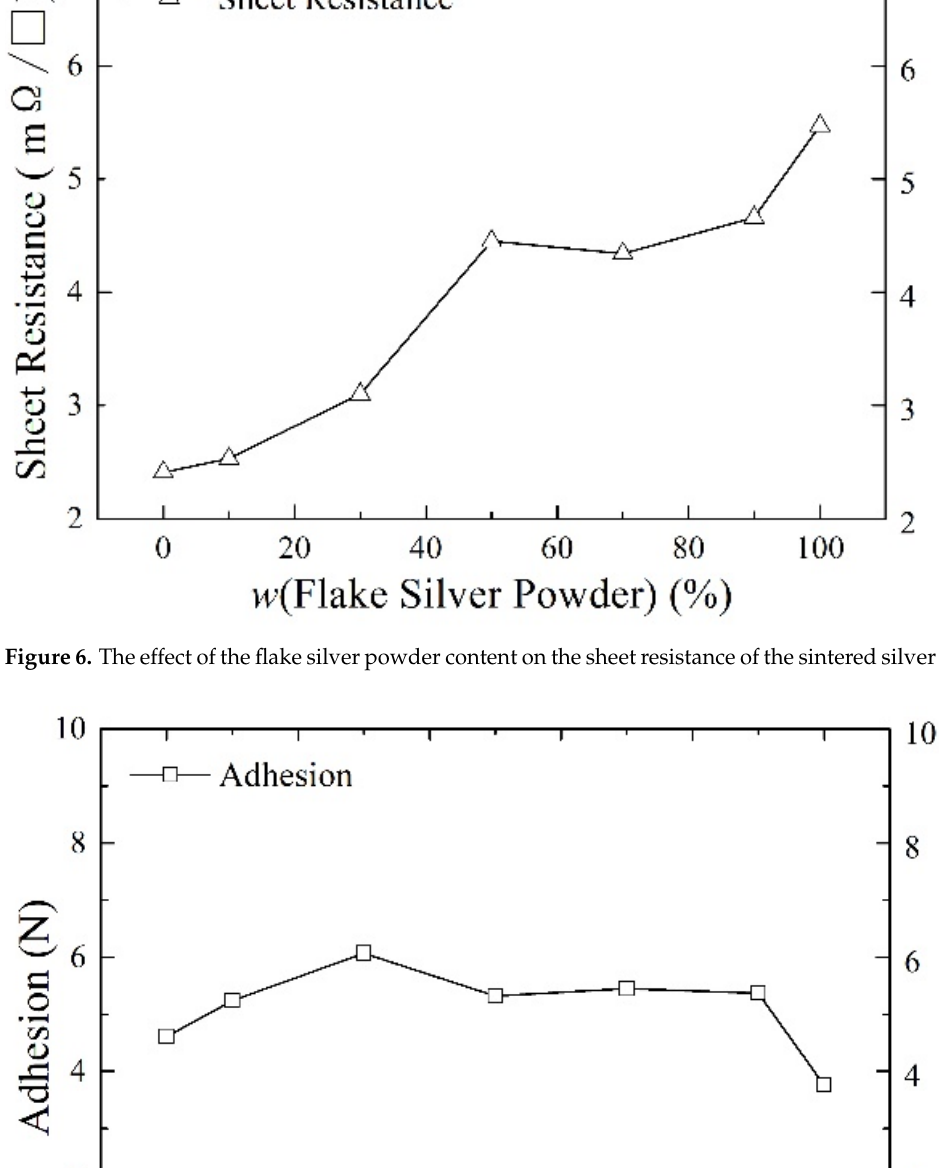
Figure 8. The effect of the flake silver powder content on the specific contact resistivity of the sin ‐ tered silver film. 3.2.1. Effect of Flake Silver Powder Content on Sheet Resistance As shown in Figure 6, the relationship between the content of the flake silver powder and the sheet resistance of the sintered silver film showed that with the increase in the content of the flake silver powder, the sheet resistance of the silver film after sintering increased continuously from 2.41 m Ω /  of pure spherical silver powder to 5.47 m Ω /  of pure flake silver powder. This is because a small amount of silver can be dissolved in the glass melt during the sintering process at medium and high temperatures, so the silver can carry out liquid phase mass transfer through the glass melt. The energy at the edge of the flake silver powder was higher, and it diffused to the middle part with lower energy through the glass melt, so the flake silver powder gradually shrank to a spherical shape.